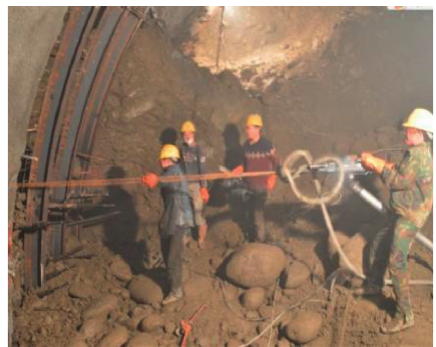
Figure 21: Bolt penetration test process.